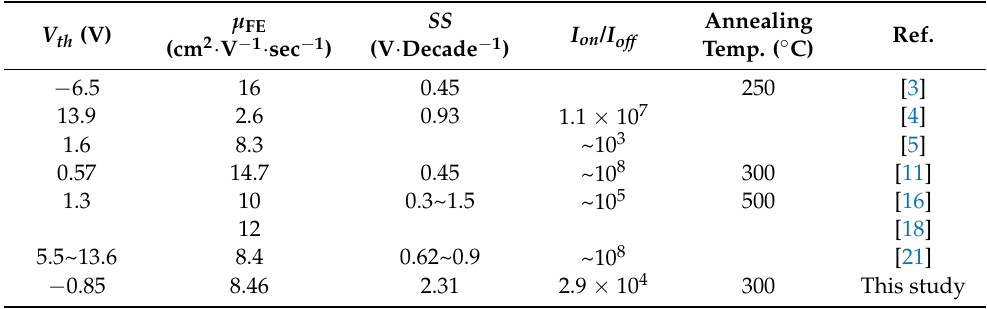
Table 7. A comparison of transfer characteristics of a -IGZO TFT devices containing an InGaZnO 4 active channel